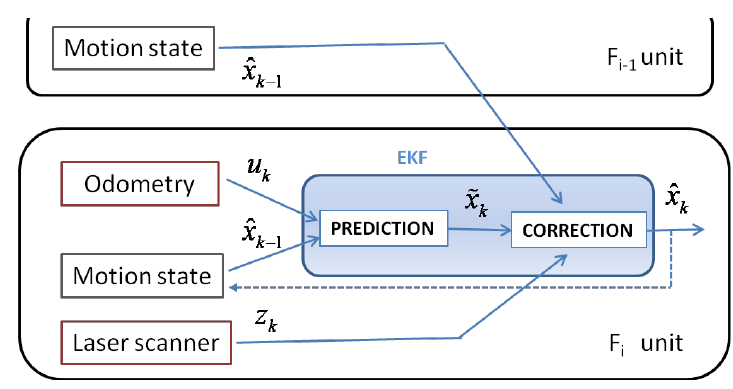
Figure 6. Processes and variables implied in the EKF to obtain the Fi movement state. 𝑋 is the predicted pose (odometry system), 𝑍 is the estimated pose (laser measurements), and 𝑋 represents the corrected pose (EKF